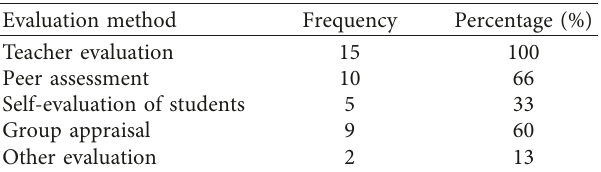
Table 8: The evaluation indexes adopted by teachers in the eval- uation of physical education teaching in pilot colleges and universities.